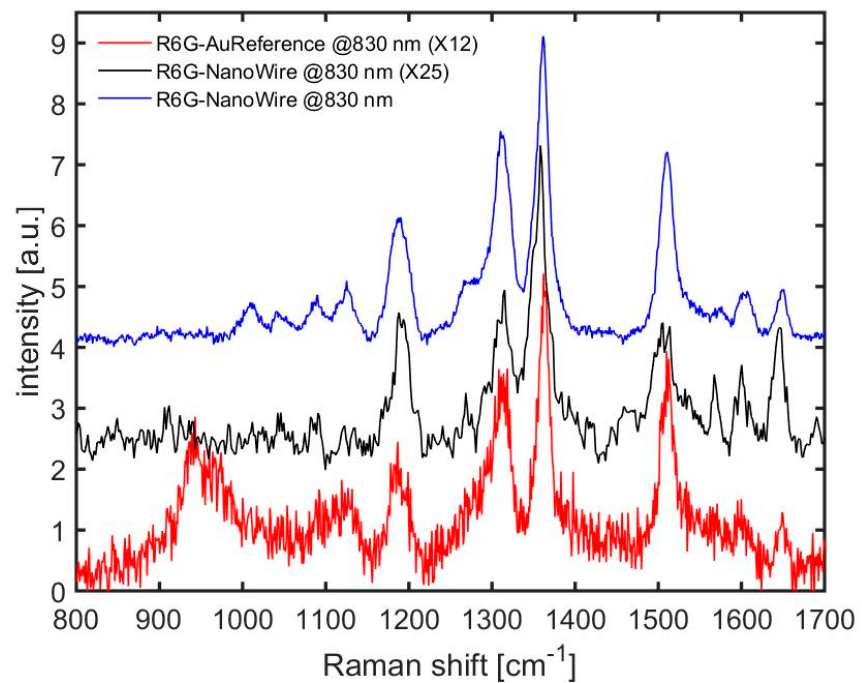
Figure 5. Raman spectra of R6G excited at 830 nm (6 mW, 1 s) and 633 nm (2 mW, 1 s). Notice the black curve is multiplied by a factor 25, for sake of comparison. The spectrum of R6G on evaporated gold reference at 830 nm excitation wavelength is also reported multiplied by a factor 12 (red curve). An additional offset is added for better presentation.